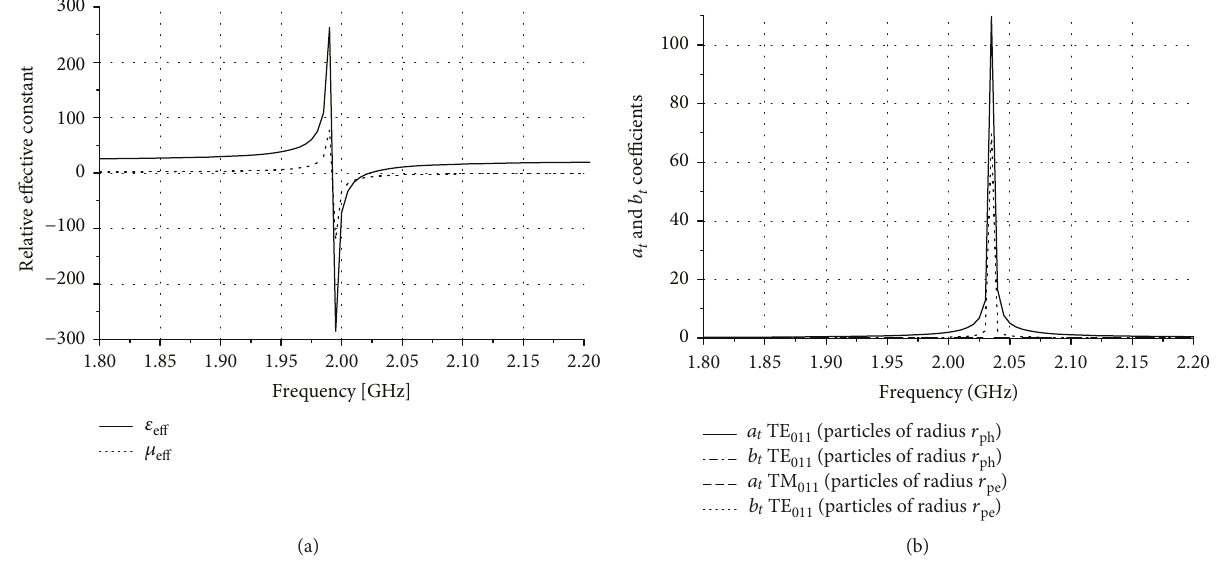
μ fi eld coe ffi cients eff and eff and (b) the